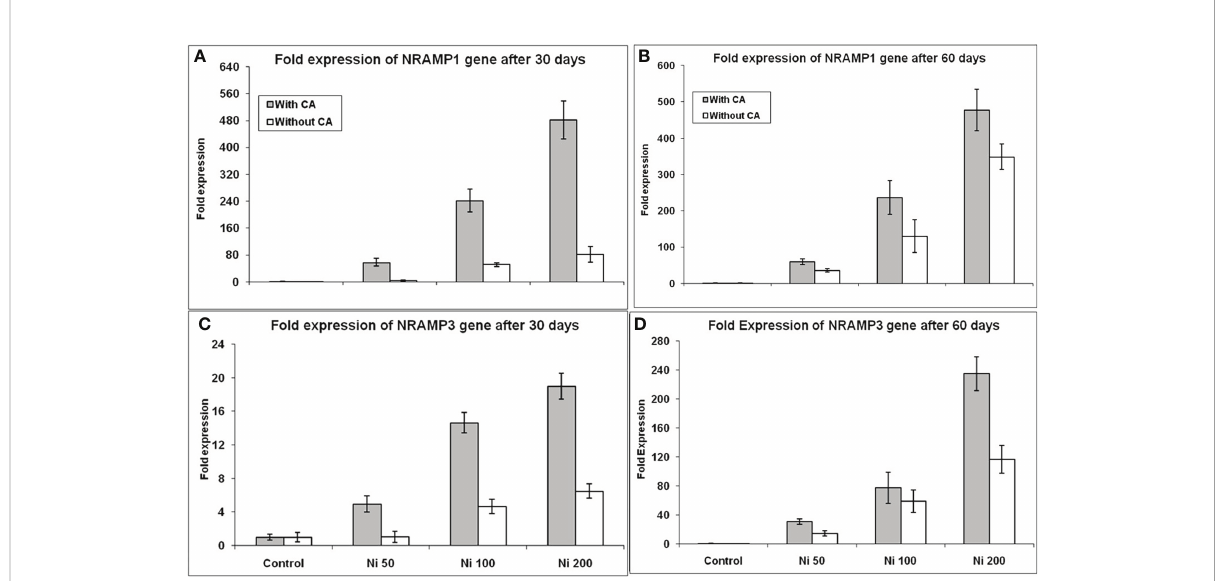
FIGURE 5 Gene expression pro fi ling of NRAMP genes under Ni stress. NRAMP1 expression on 30 th day (A) , NRAMP1 expression on 60 th day (B) , NRAMP3 expression on 30 th day (C) , and NRAMP3 expression on 60 th day (D) , in sun fl ower plants. The bars designated with Ni 50, Ni 100, and Ni 200 represent Ni concentration at 50, 100, and 200ppm, respectively. “ With CA ” means these Ni-stressed plants are supplemented with 5 mM CA and vice versa for “ Without CA ”